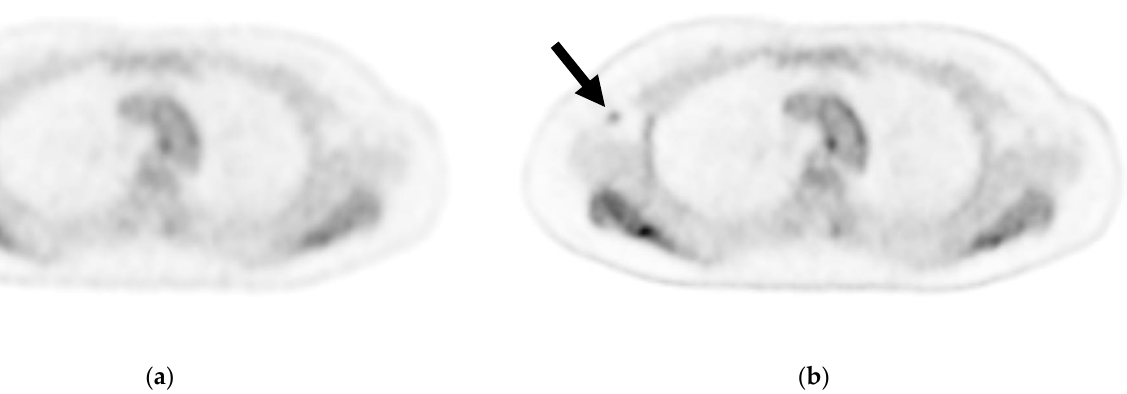
Figure 2. Axial image of an axillary lymph node (ALN) cross ‐ section via ( a ) cPET and ( b ) DL ‐ PET of a woman in her 40 s with invasive lobular carcinoma in the right breast: invasive diameter, 18 mm; nuclear grade, 1; lymphatic invasion, positive; vascular invasion, positive; estrogen receptor, positive; progesterone receptor, positive; HER2 receptor, negative; Ki ‐ 67 staining, 17.3%; and nodal stage, 1a. Of 18 ALNs, 3 were positive for metastasis; the maximum diameter was 3 mm, and an extranodal invasion was evident. Visual analysis for ipsilateral ALN metastasis was rated on a scale of 1–3 (1 = negative, 2 = intermediate, 3 = positive). For ALN metastasis, reader 1 gave a score of 2 for cPET and 3 for DL ‐ PET, and reader 2 gave a score of 1 for both the PET types. cPET, PET with conventional reconstruction; DL ‐ PET, PET with deep learning restoration.